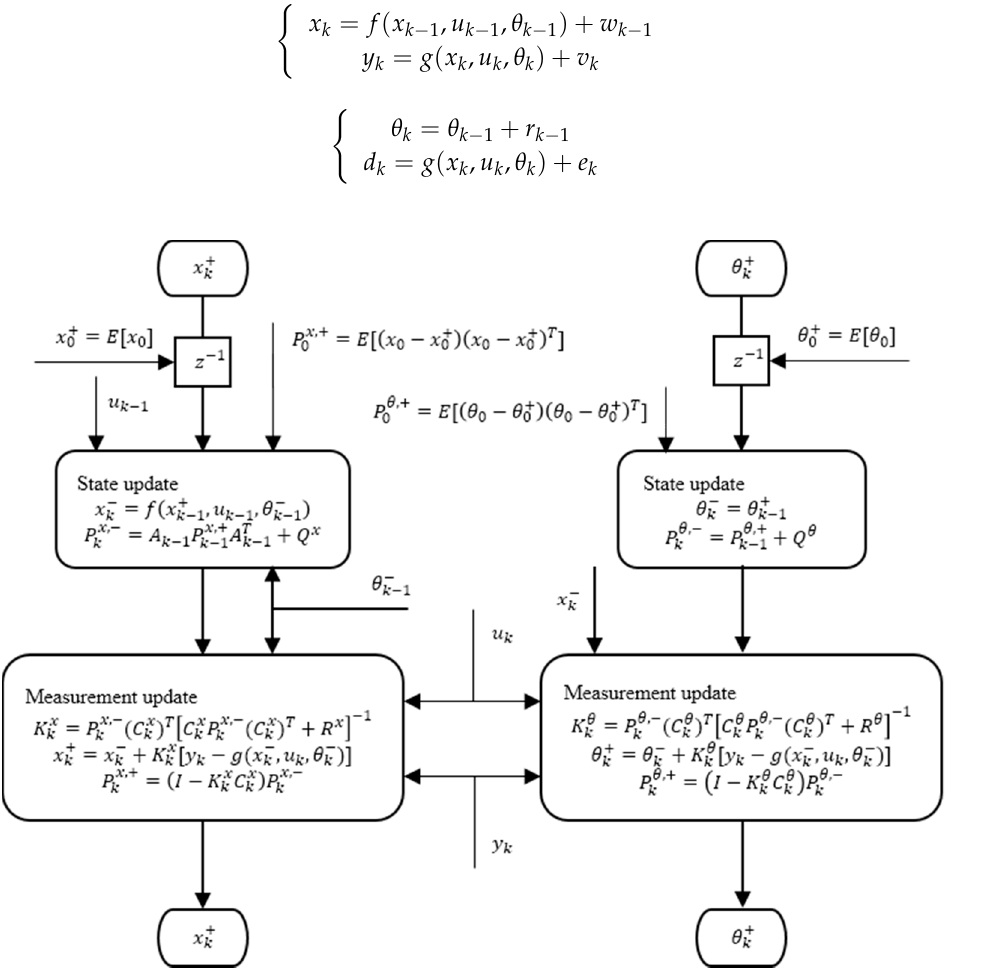
Figure 2. The dual extended Kalman filtering algorithm.